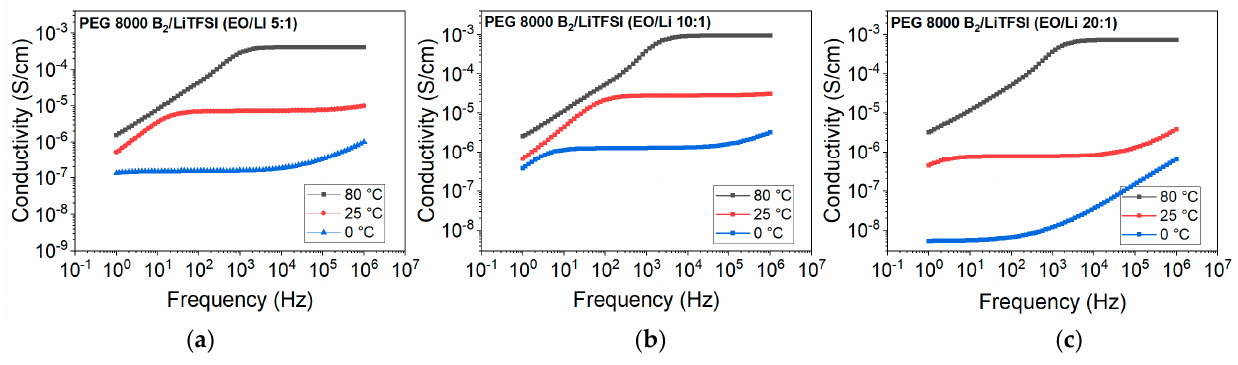
Figure 10. Frequency dependent ionic conductivity of ( a ) PEG 8000 B 2 /LiTFSI mixture (EO:Li 5:1) ( 8 ); ( b ) PEG 8000 B 2 /LiTFSI mixture (EO:Li 10:1) ( 9 ); ( c ) PEG 8000 B 2 /LiTFSI mixture (EO:Li 20:1) ( 10 ).